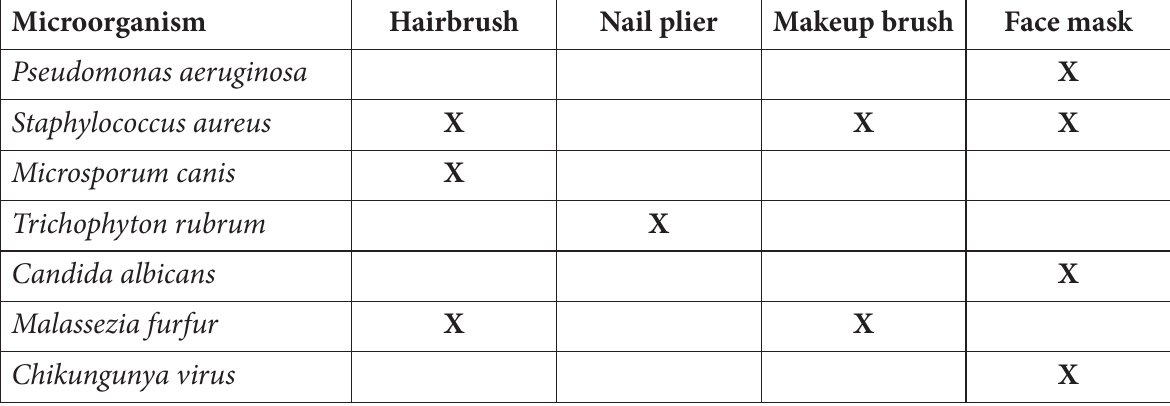
Table 1 . Microorganisms and tools